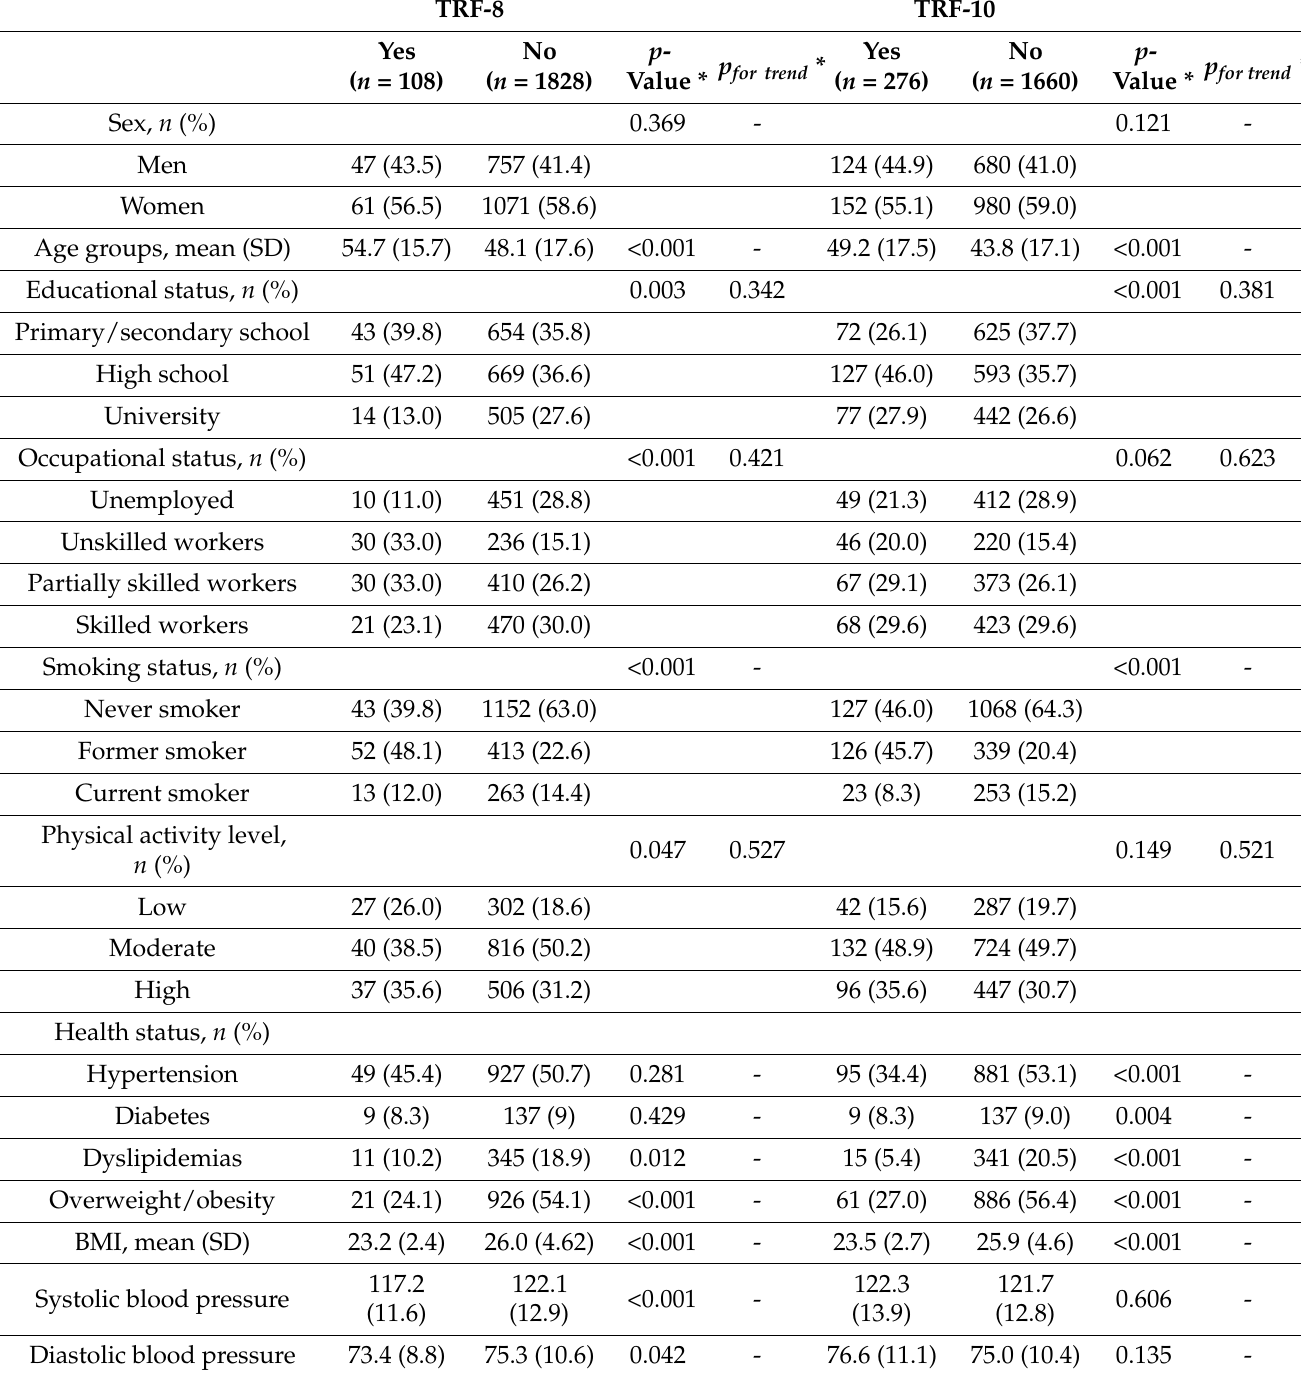
Table 1. Background characteristics of the study population according to time-restricted feeding